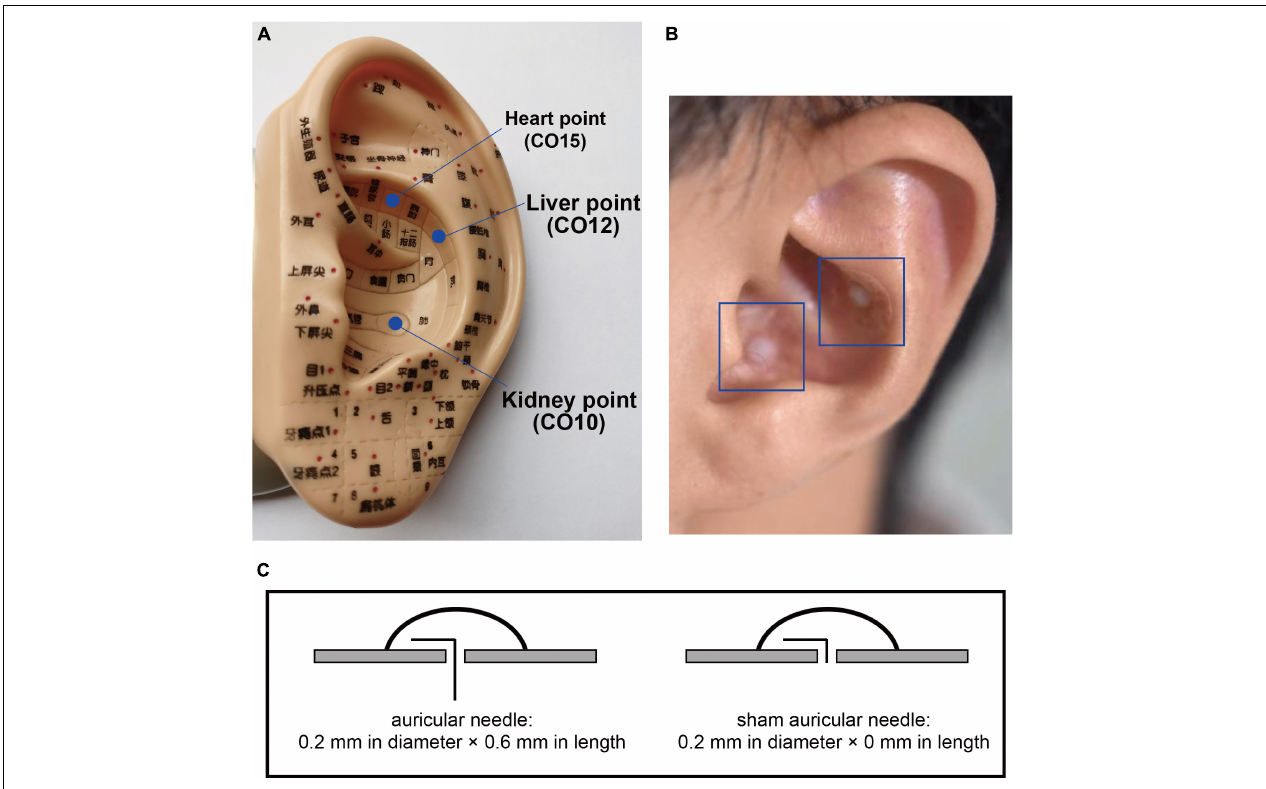
FIGURE 7 | Auricular points and needles. The locations of selected auricular points are shown in (A) ; the intervention methods of the auricular needles and sham needles are shown in (B) and (C)